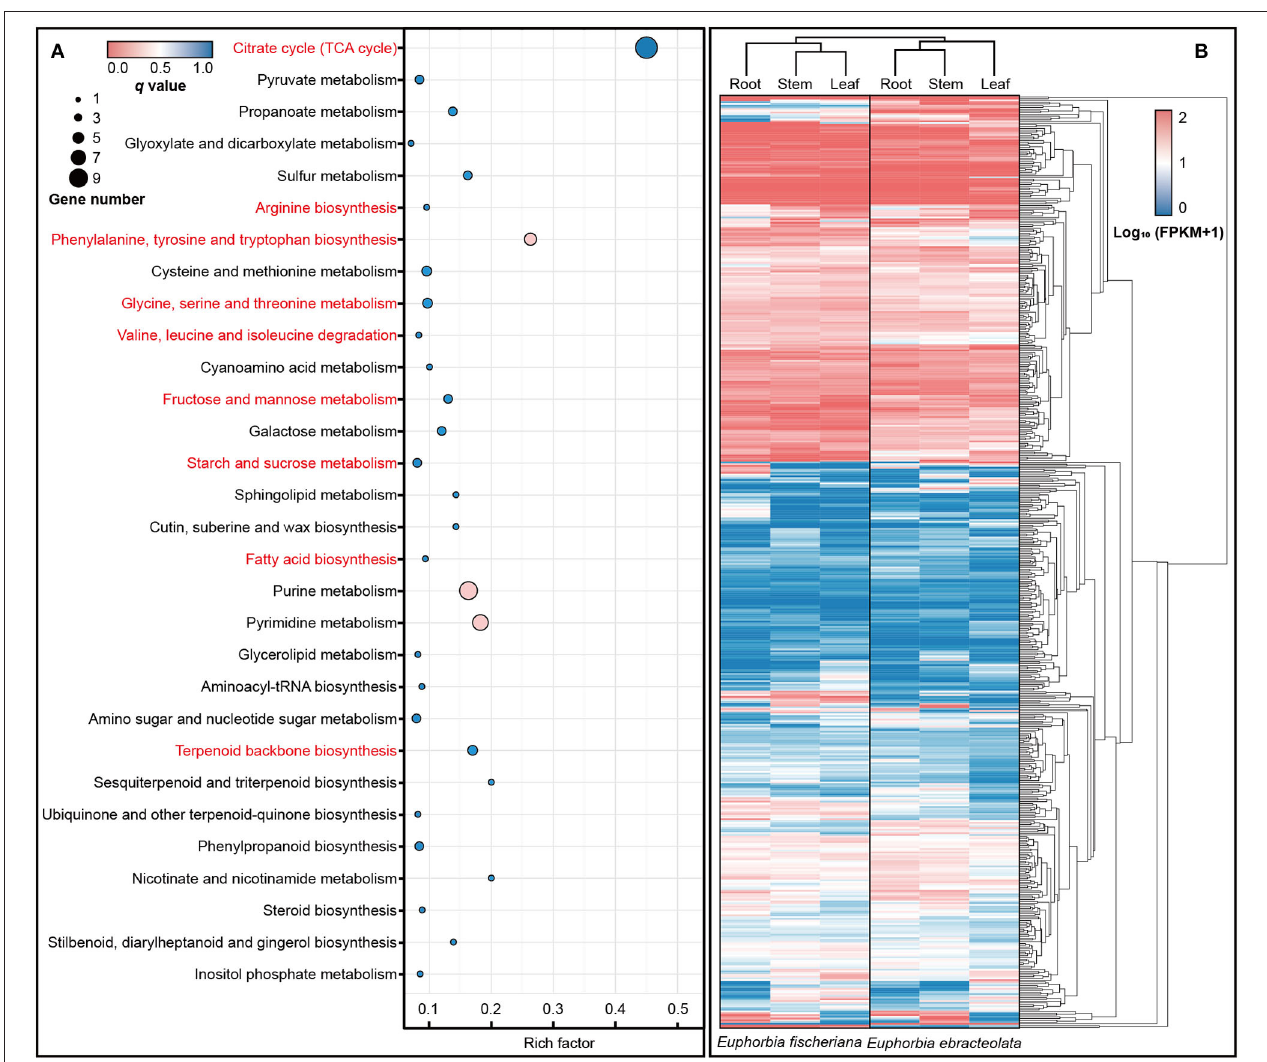
FIGURE 4 | KEGG enrichment and expression differences of orthologous genes. (A) KEGG enrichment of orthologous genes (Ka/Ks > 0.5); (B) Heat map of orthologous genes (Ka/Ks > 0.5) expression in roots, stems, and leaves.